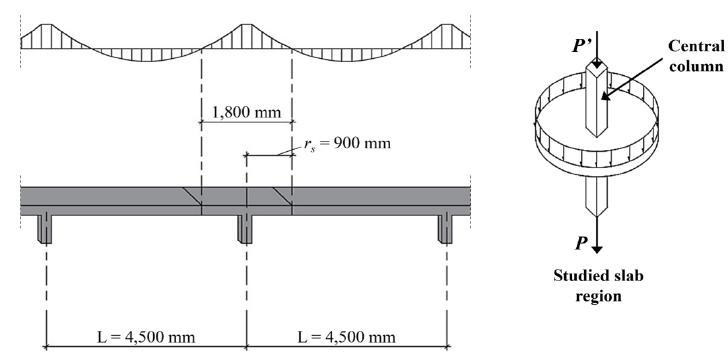
Figure 3. Idealized interior panel characterizing the situation studied (Lourenço